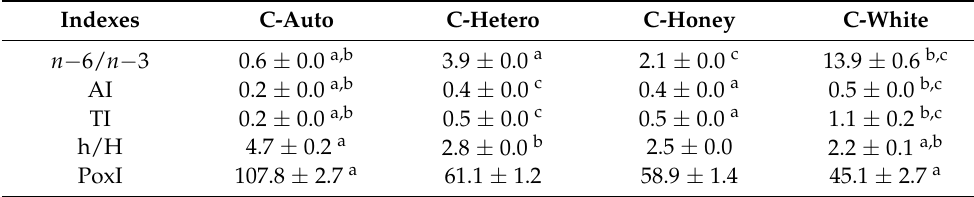
Table 2. Lipidic quality indexes of the total lipid extracts of four Chlorella vulgaris strains, C-Auto, C-Hetero, C-Honey, and C-White. Data are represented as means ± SD, n = 5. Values with the same letter ( a , b , or c ) are statistically different ( q <